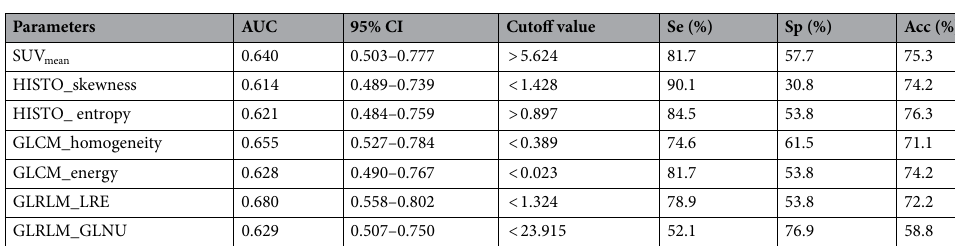
Table 2. Predictive value of RFS according to ROC analysis. SUV standardized uptake value, HISTO histogram, GLCM grey level co-occurrence matrix, GLRLM grey level run-length matrix, LRE long run emphasis, GLNU gray level non-uniformity for run, AUC area under curve, CI confidence interval, Se sensitivity, Sp specificity, Acc